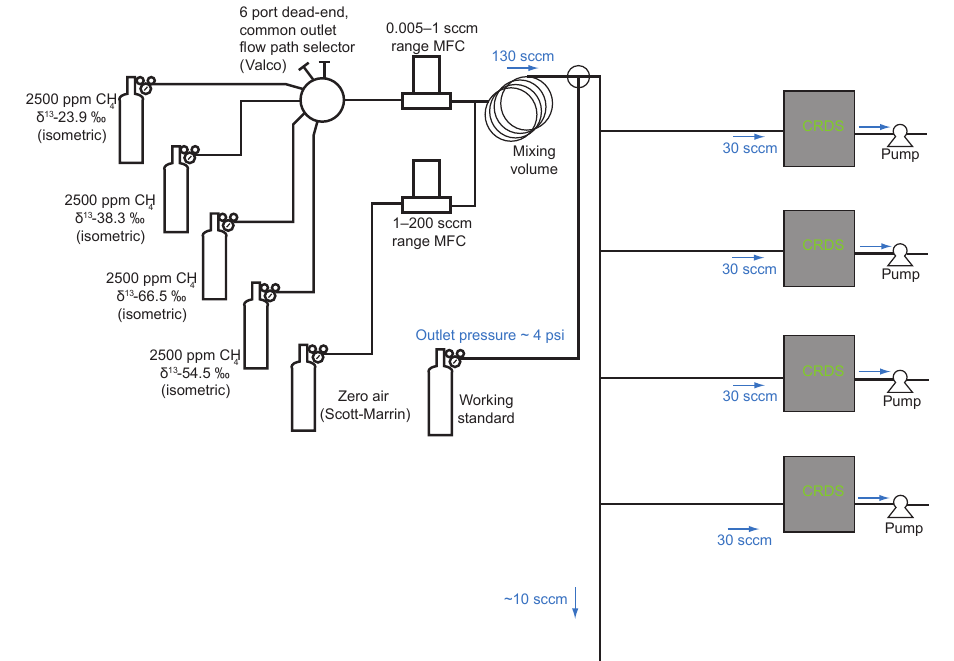
Figure 3. Flow diagram of the experimental setup used for the laboratory calibration of the analyzers and the field tanks (working standards). At standard pressure and temperature, the gas volume of the zero air and working standard tanks was 4021L, and that of the Isometric Instruments bottles was 28L.